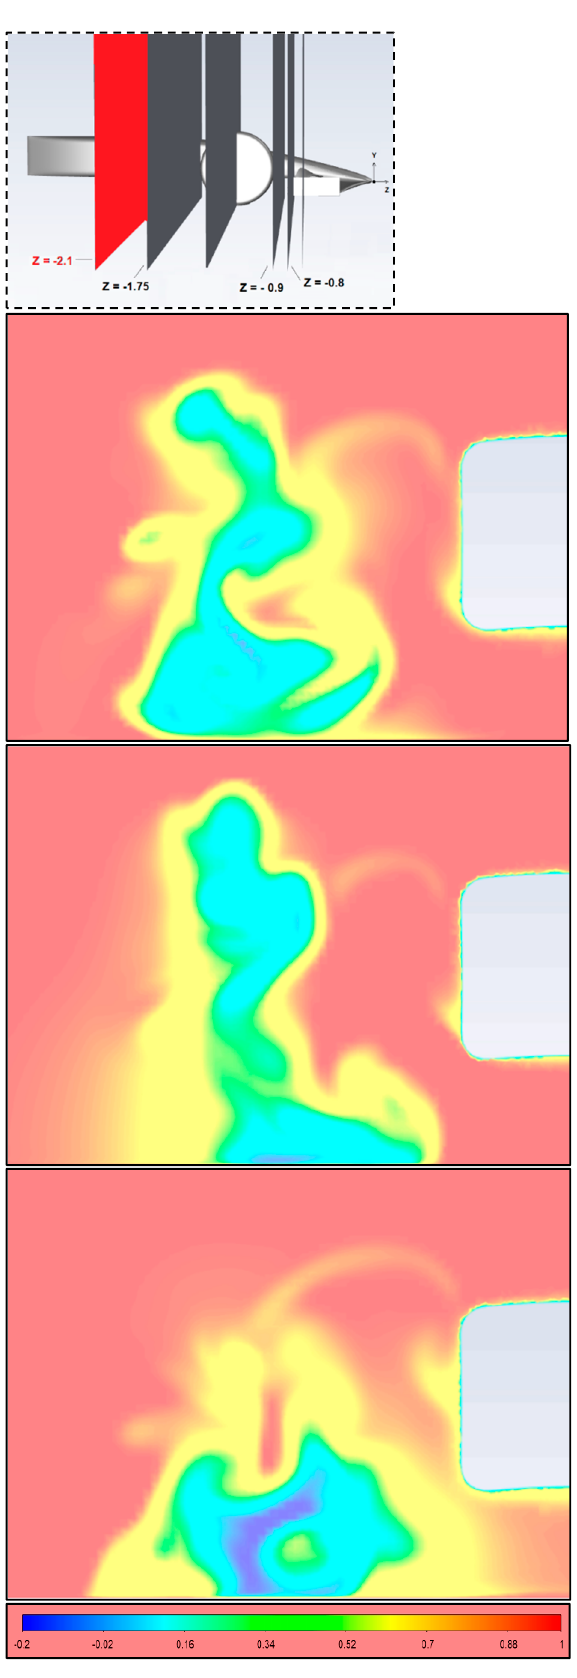
Figure 12. Streamwise velocity at plane (cid:1878) = −2.1 (underbody intake) (AOA of 30°, 32°, and 34°).